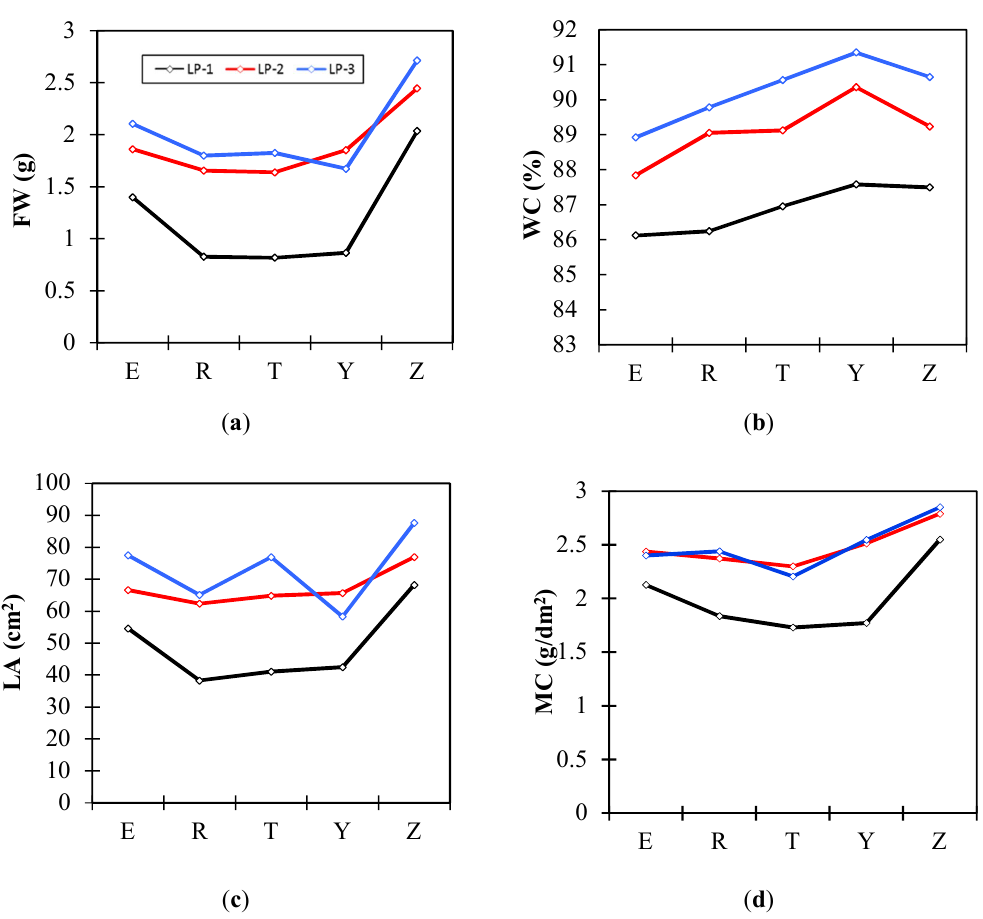
Figure 5. Tomato leaf characteristics of five cultivars under different height layers. ( a ) Fresh weight; ( b ) water content; ( c ) leaf area; ( d ) equivalent water thickness (g/dm 2 ). E: Endeavour; R: Rinnka409; T: Tomimaru mucyo; Y: CF Momotarou; Z: DR03-103.